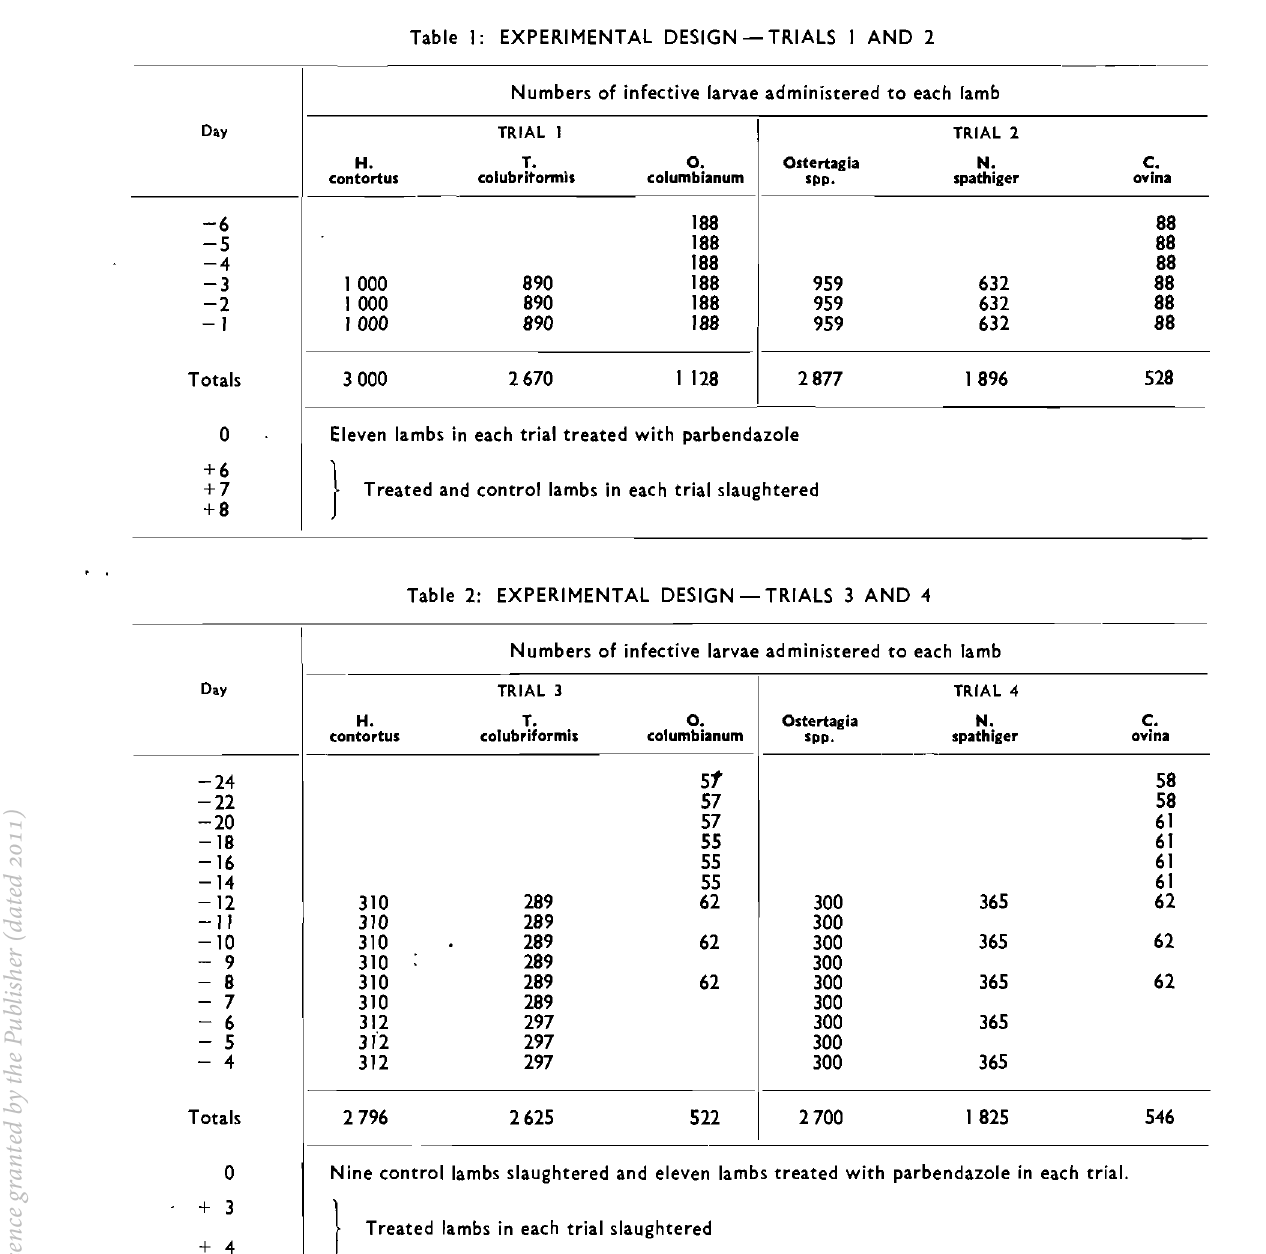
Table 1: EXPERIMENTAL DESIGN - TRIALS 1 AND 2